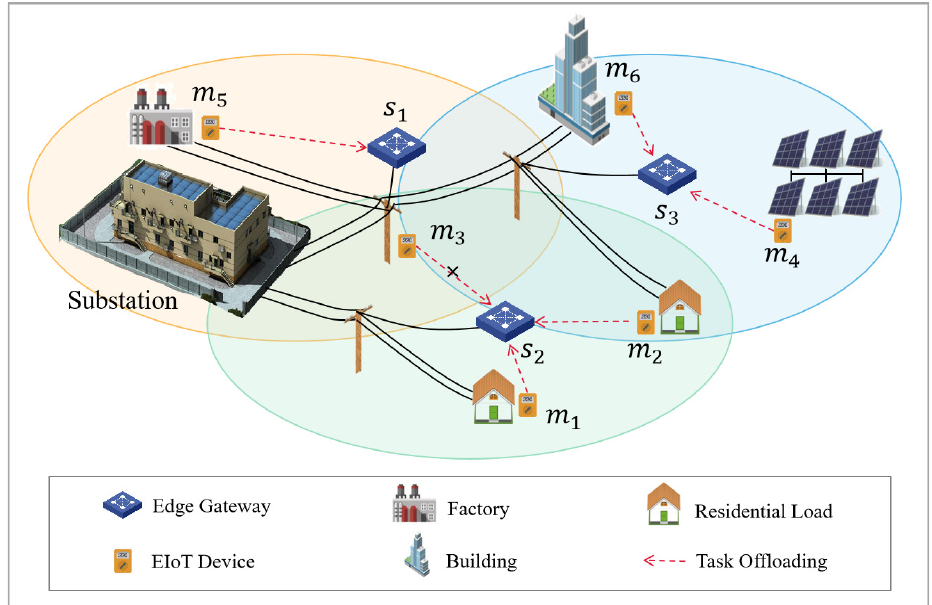
Figure 1. Task offloading model for